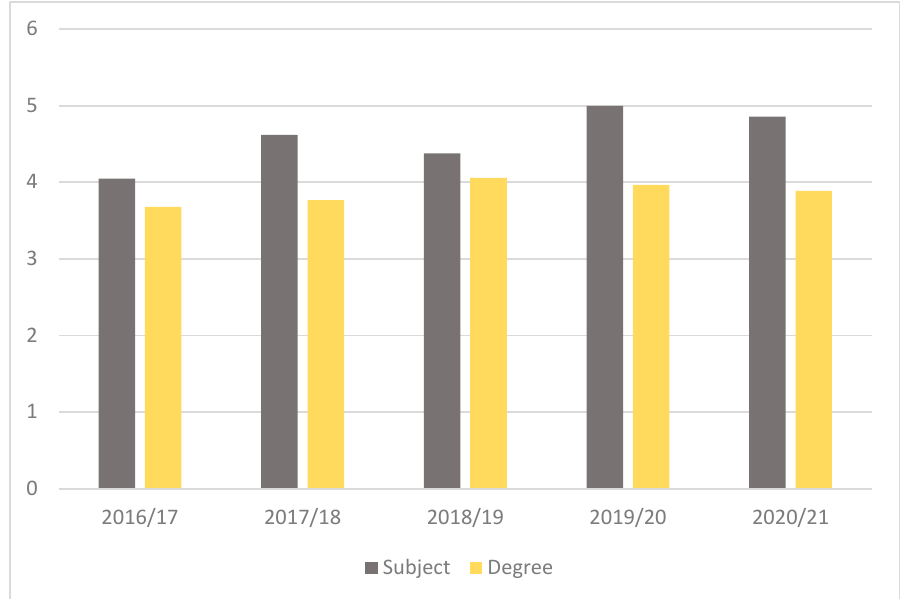
Figure 2. Results of the subject vs. results of the degree with respect to the teaching methodology.